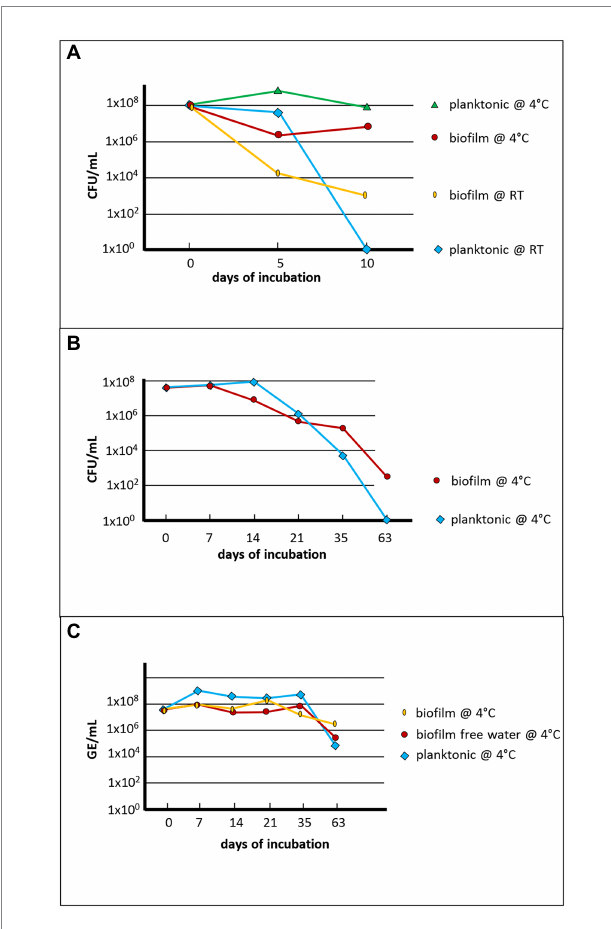
FIGURE 4 Quantification of Fth’ survival in natural ex vivo biofilm. The number of colony forming units (CFU) of Fth and the genome equivalents (GE) were measured over time of the representative experiment conducted in November of the year. (A) Comparison of survival of planktonic Fth and Fth in the biofilm at room temperature and at 4 ° C; (B) Long term survival of planktonic Fth and Fth in the biofilm in natural water at 4 ° C; (C) The same experiment as shown in (B) , but detection of Fth DNA in biofilm, in planktonic supernatant from the biofilm, and in natural water without previous biofilm formation (control). The Thermanox ™ coverslips overgrown with or without biofilm in NSW were infected with 4×10 7 F. tularensis on day 0. At several time points as indicated, CFU and GE were determined from the NSW or the supernatant of the coverslips, and of the scraped biofilm (see Material and